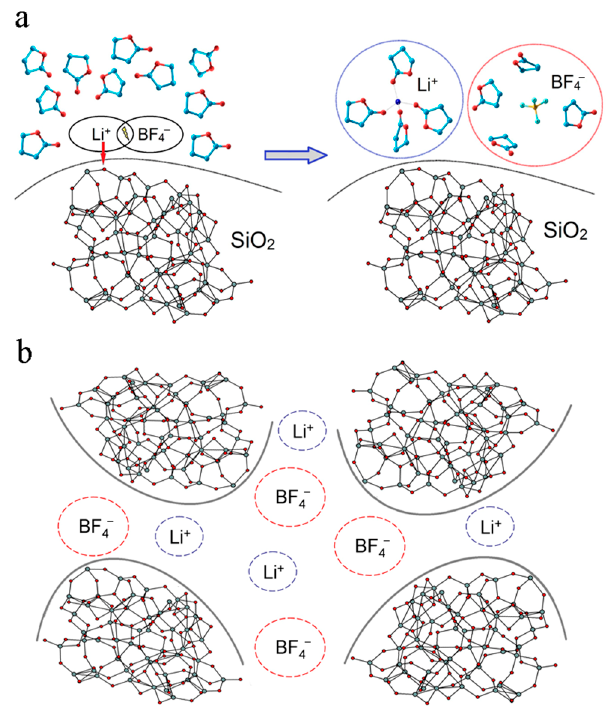
Figure 33. Scheme of ionic transport in the nanocomposite polymer electrolyte: ( a ) mechanism of LiBF 4 salt dissociation to ions involving SiO 2 surface groups; ( b ) ion transport over the surface of nanoparticles. Solvate shells of ions and ion pairs are designated by oblong dashed circles [65].